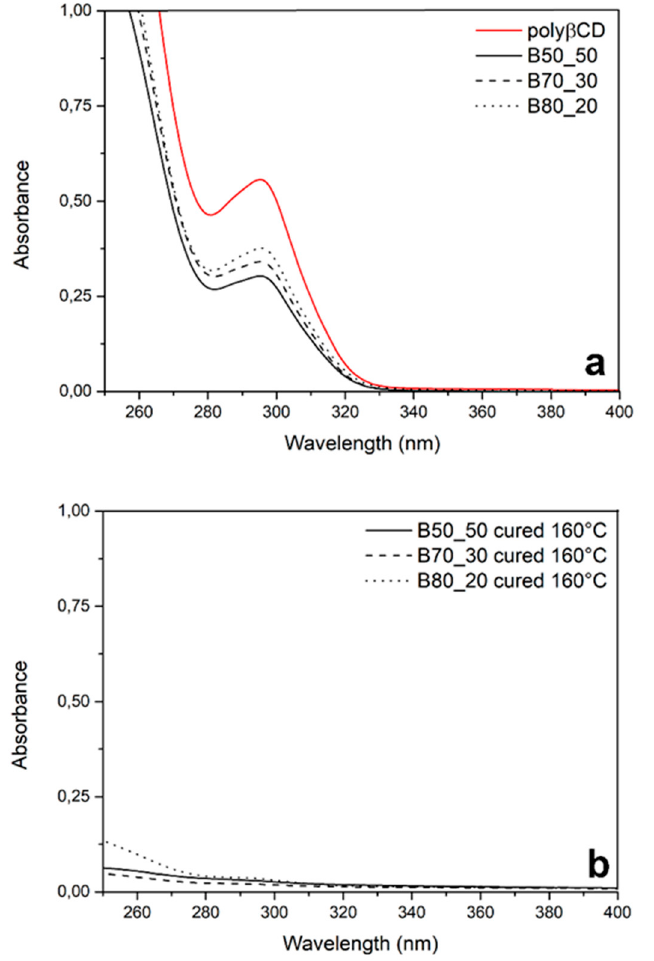
Figure 6. UV-vis spectra of water solutions of as-spun fibers ( a ) and of fibers cured at 160 °C ( b